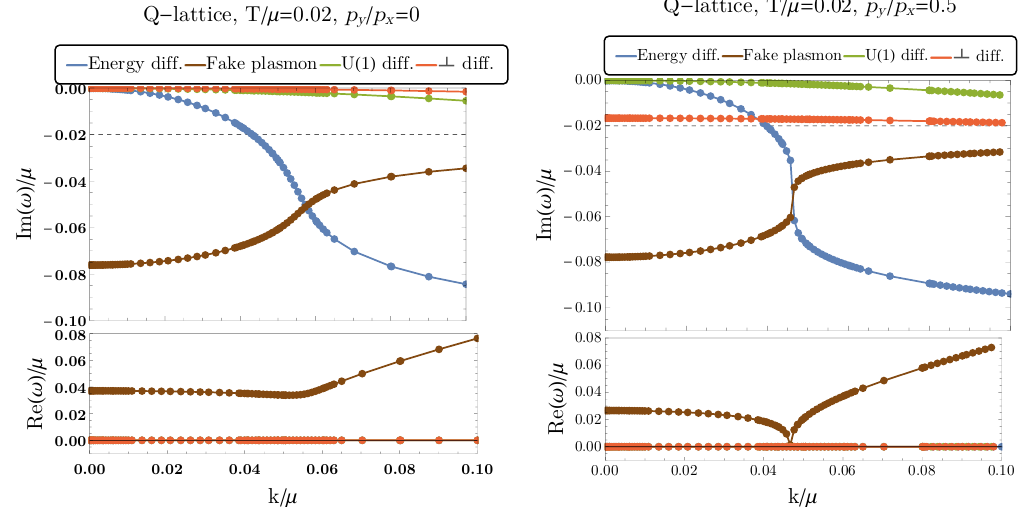
Figure 10. QNMs at intermediate T for various anisotropies. The anisotropic TSB ratio modi(cid:12)es the fake plasmon dispersion. Depending on the relative TSB strength in each direction, the gapped fake plasmon may approach and touch the imaginary